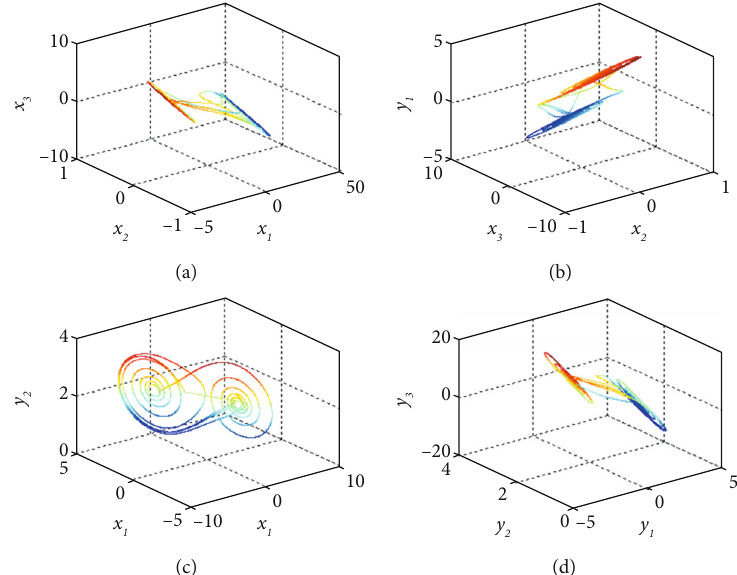
Figure 12: The chaotic trajectory of the unidirectionally coupled Chua ’ s circuit with the linear manifold y = Px + Q in 3D phase space: (a) − x − x − x − y − y − y − y − y ; (b) x ; (c) x ; (d) y . x 1 2 3 2 3 3 1 1 2 1 2 3